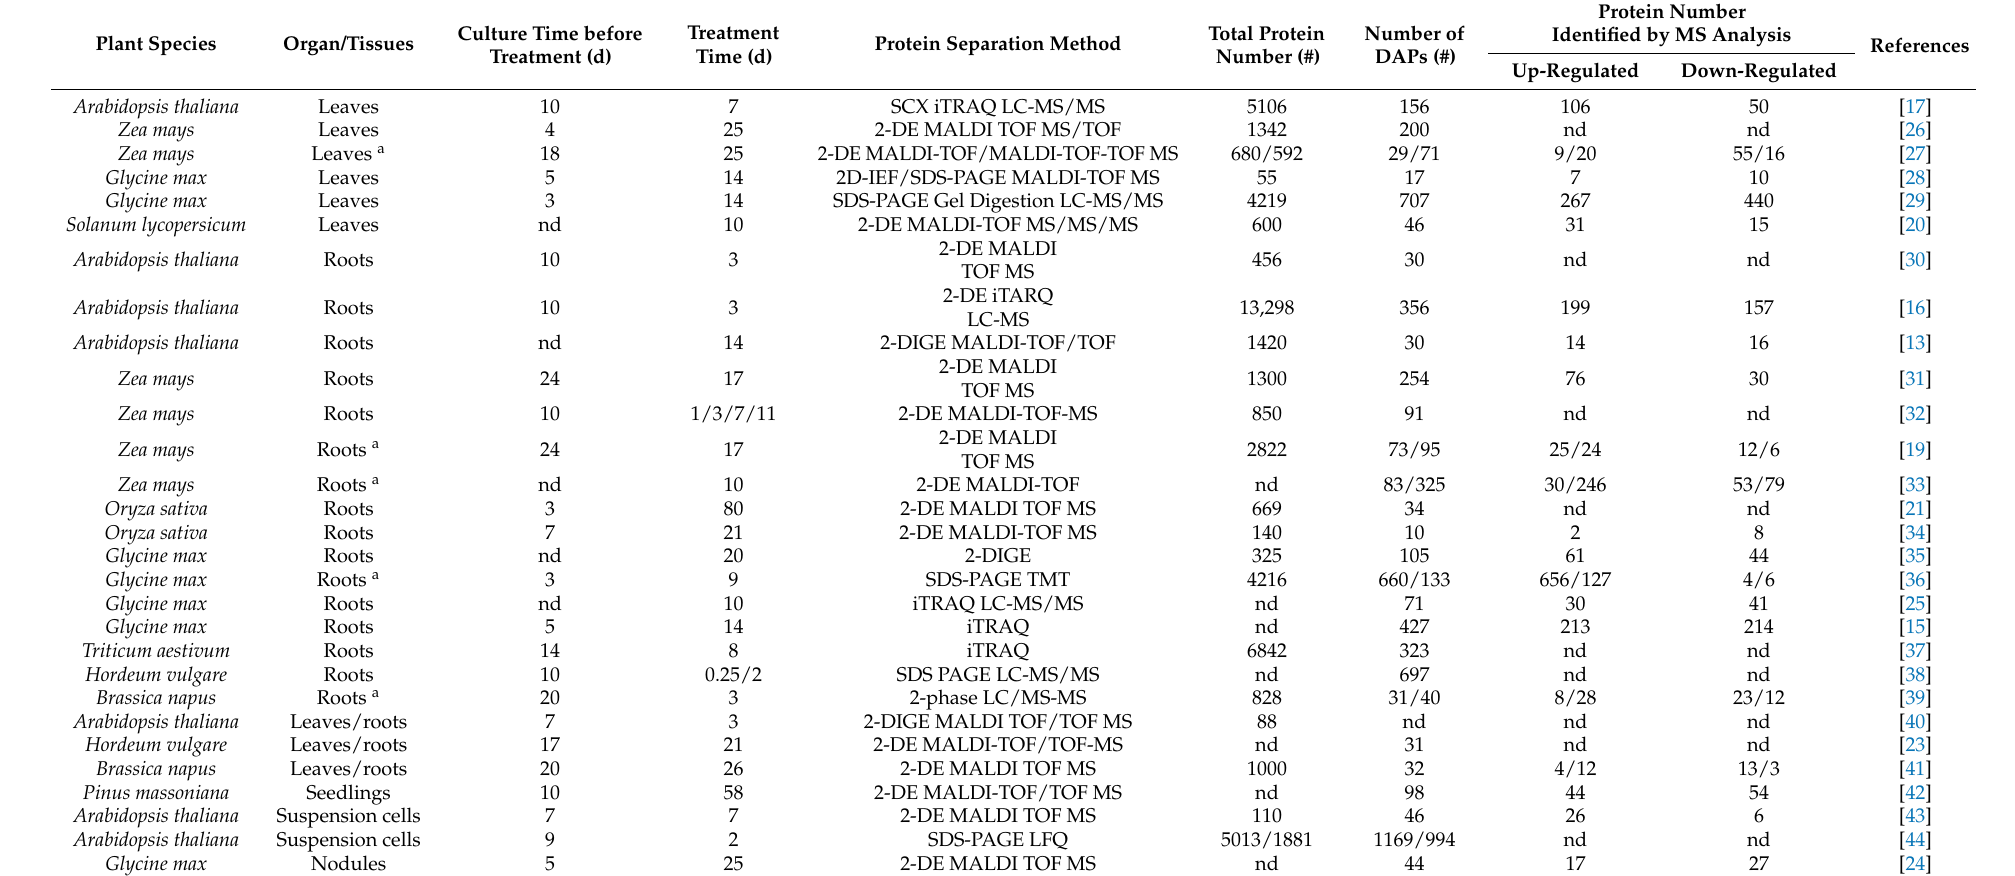
Table 1. A list of proteomic analyses of plant responses to phosphorus